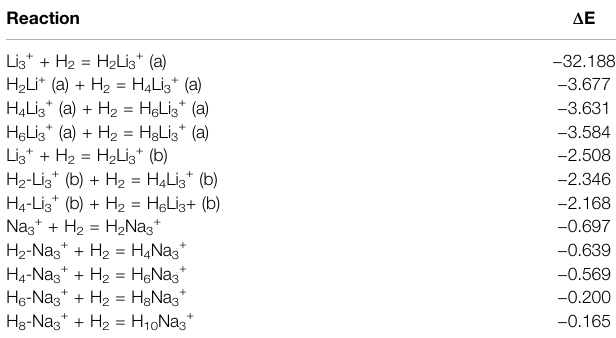
TABLE1| Reactionenergyinkcal/molforthegradualhydrogenloadingonLi 3+ and Na 3+ clusters(AdaptedwithpermissionfromSpringerNatureCustomerService CentreGmbH: Journal ofMolecular Modeling(Giriet al.,2011a),Copyright © 2010, Springer-Verlag). Reaction